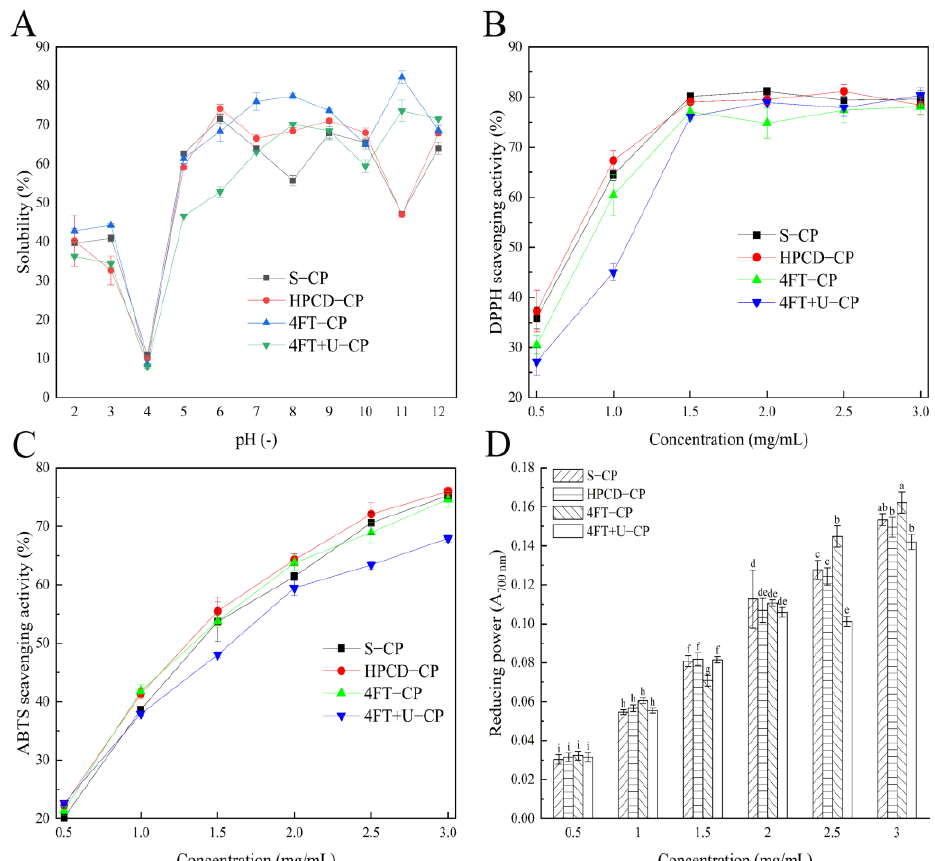
Figure 4. Solubility ( A ), free radical scavenging activities, and total reducing power of CPs obtained using different methods: DPPH radical scavenging activity ( B ), ABTS radical scavenging activity ( C ), and total reducing power ( D ). Different lowercase letters indicate significant differences ( p < 0.05).